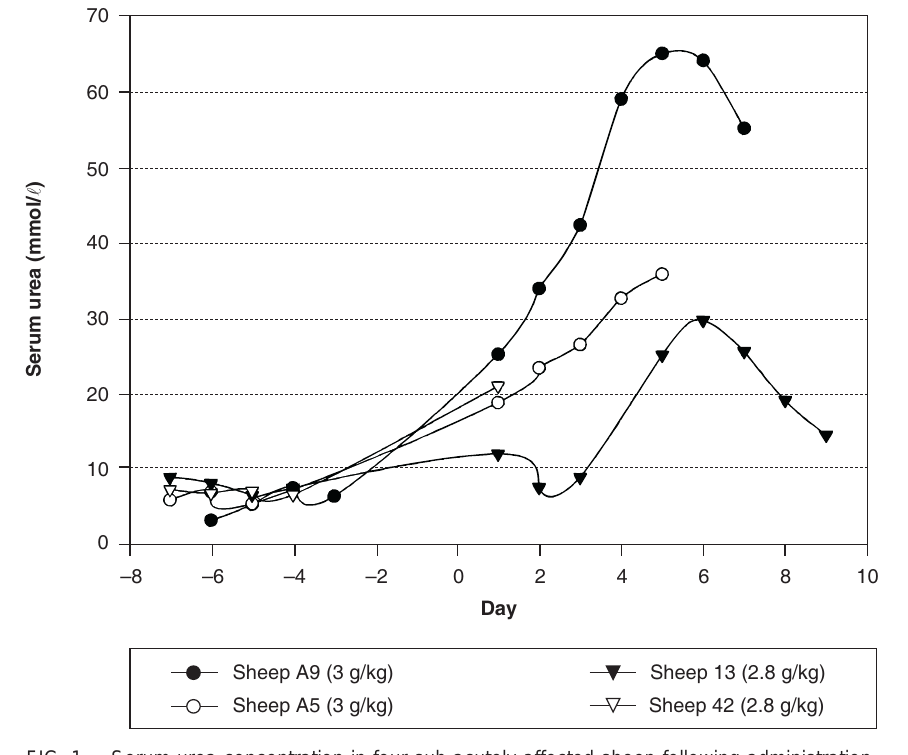
FIG. 1 Serum urea concentration in four sub-acutely affected sheep following administration of dried, milled Nolletia gariepina plant material